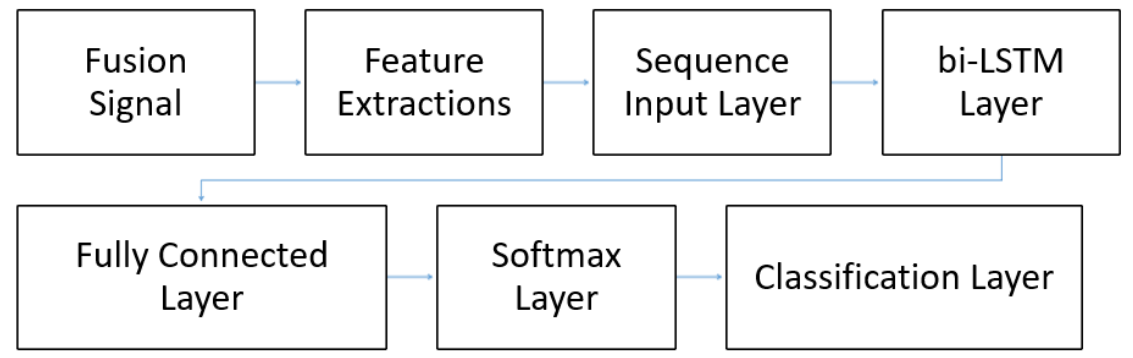
Figure 7. The biometric model architecture with PPG and ECG fusion input.